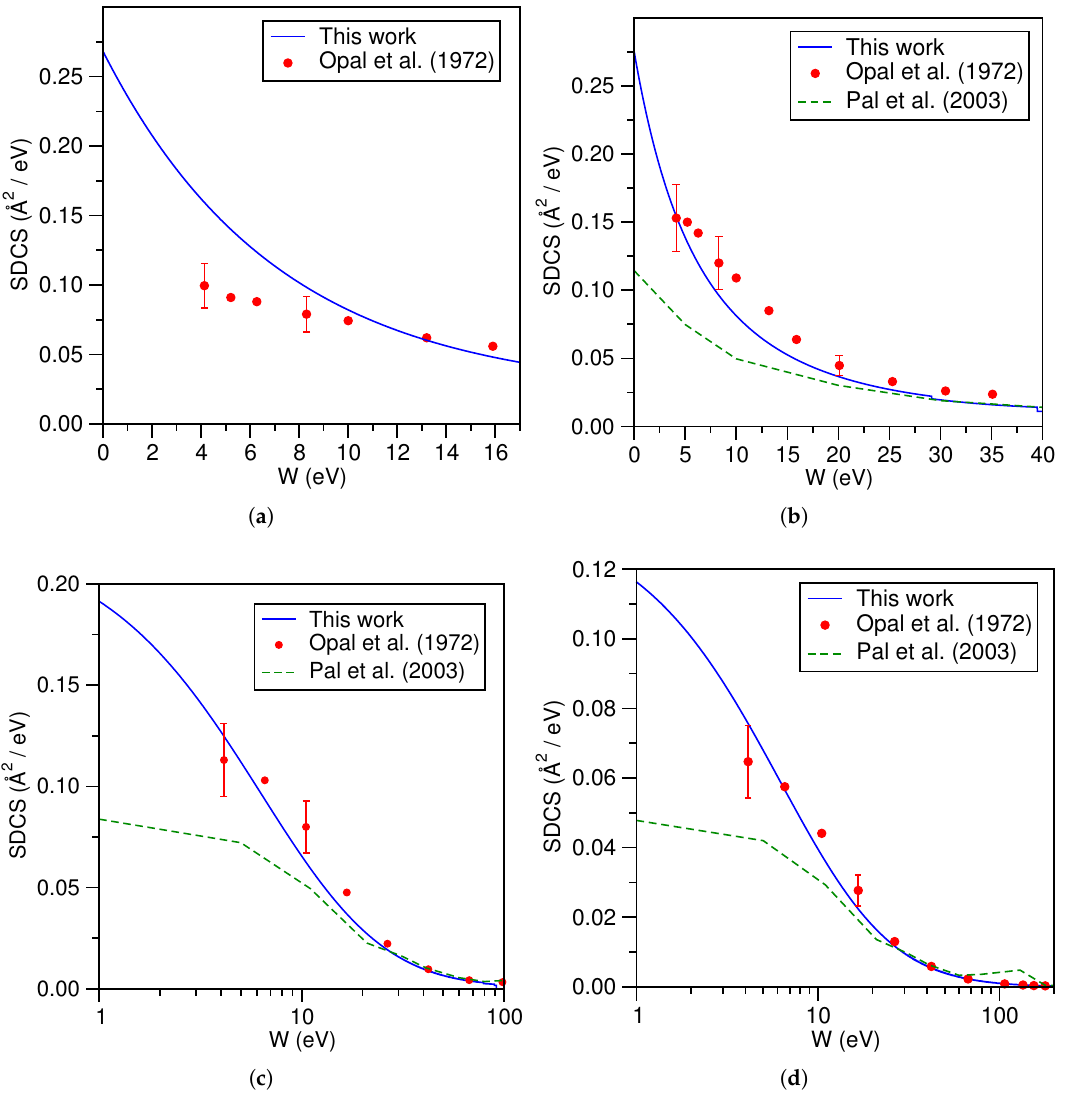
Figure 4. Electron-impact SDCS for N 2 at a primary electron energy of ( a ) T = 50 eV, ( b ) T = 100 eV, ( c ) T = 200 eV, and ( d ) T = 500 eV. The solid lines represent the present results, the dashed lines are the results of Pal et al. [39], and the filled circles are the experimental measurements of Opal et al.